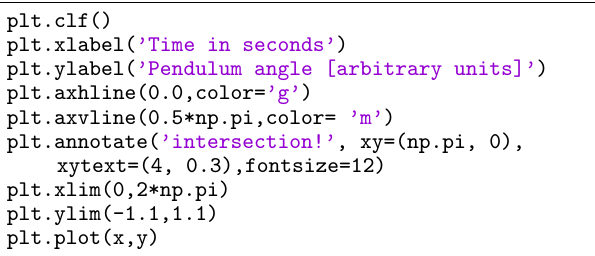
“annotate”, and it works as follows: